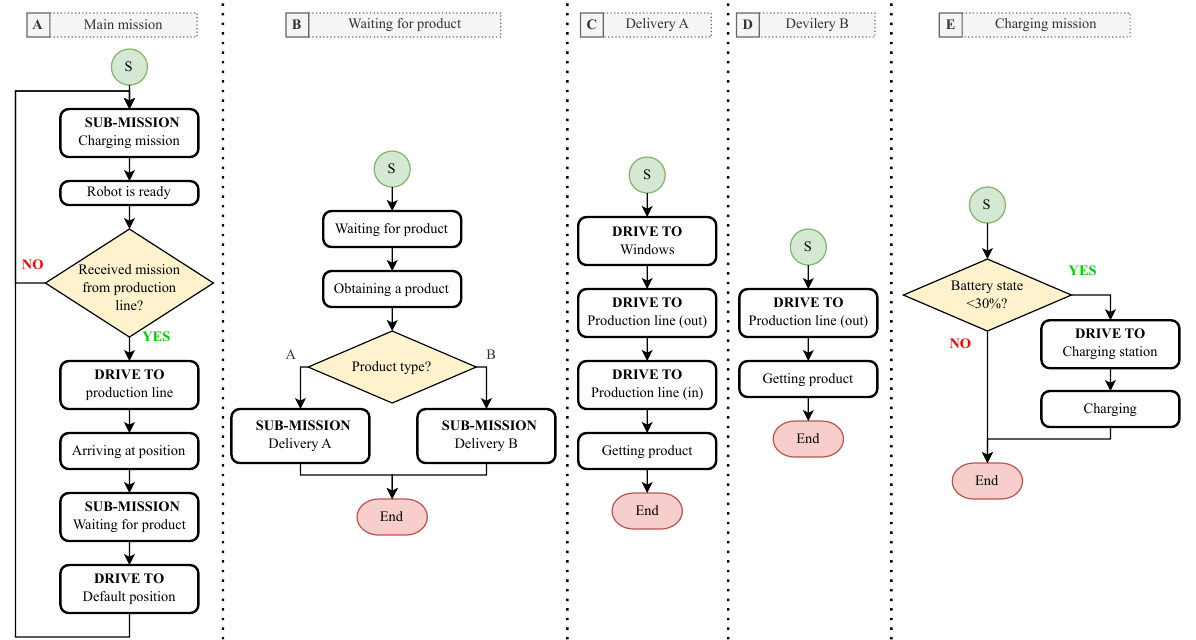
Figure 8. Program functionality